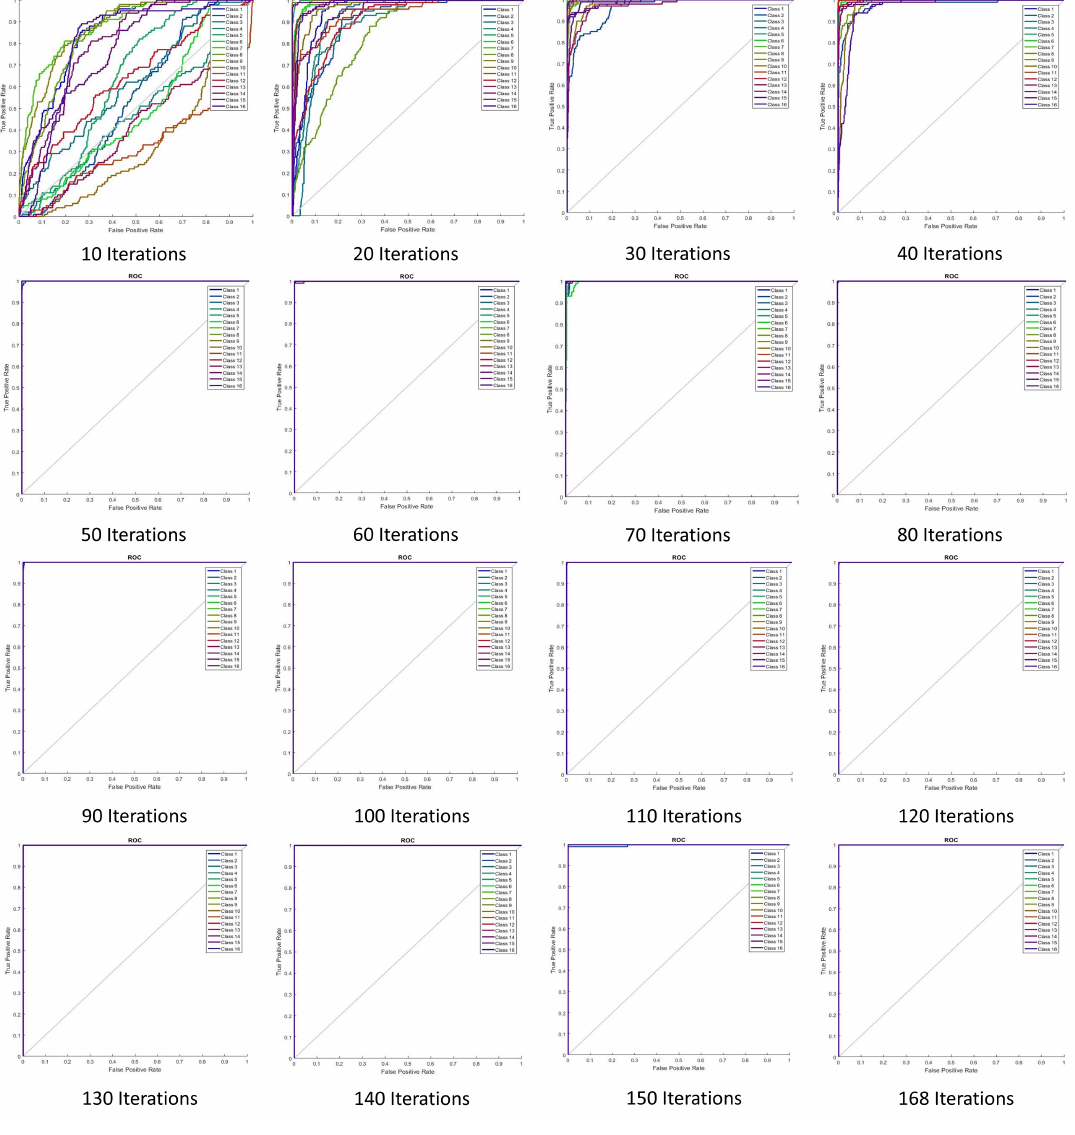
Figure 10. Neural network training performance with respect to the receiver operating characteristic (ROC)